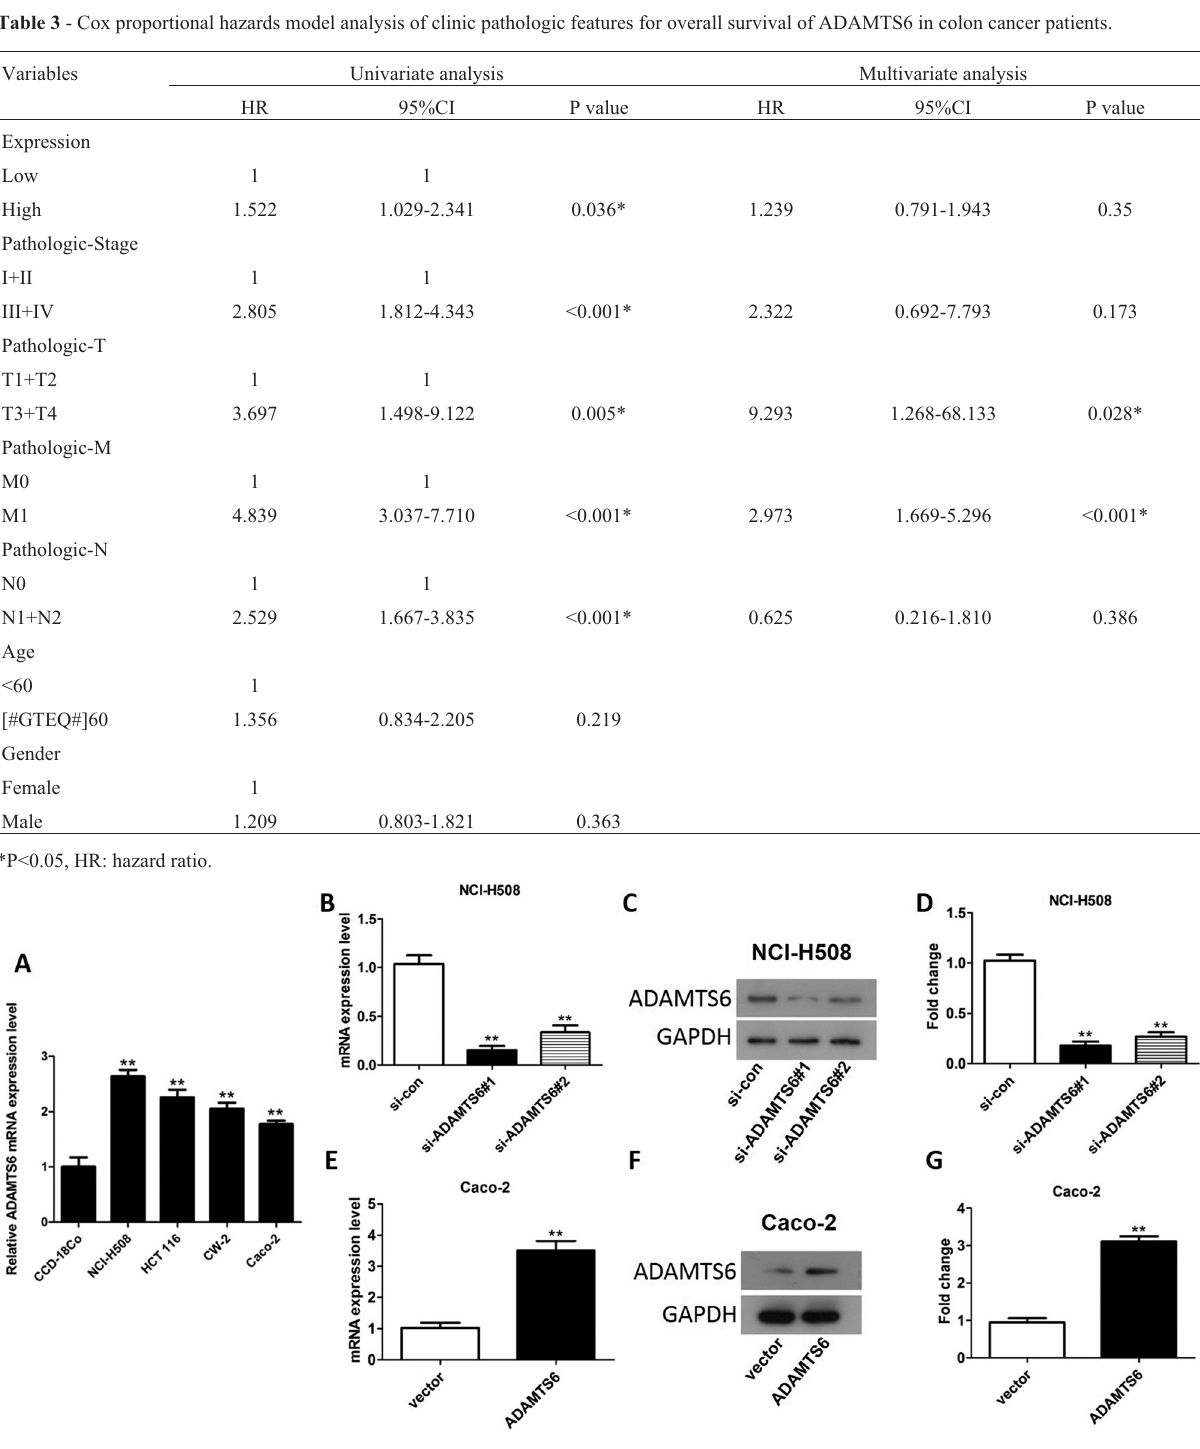
Figure2 -TheexpressionofADAMTS6incoloncancercelllines.(A)TheexpressionofADAMTS6inCCD-18Co,NCI-H508,Caco-2,CW-2andHCT 116 cell lines. **P <0.01 vs. CCD-18Co. (B) The mRNA expression of ADAMTS6 in NCI-H508 cells. (C, D) The protein levels of ADAMTS6 in NCI-H508cells.(E)ThemRNAlevelsofADAMTS6inCaco-2cells.(F,G)TheproteinlevelsofADAMTS6inCaco-2cells.**P<0.01vs.si-controlor vector